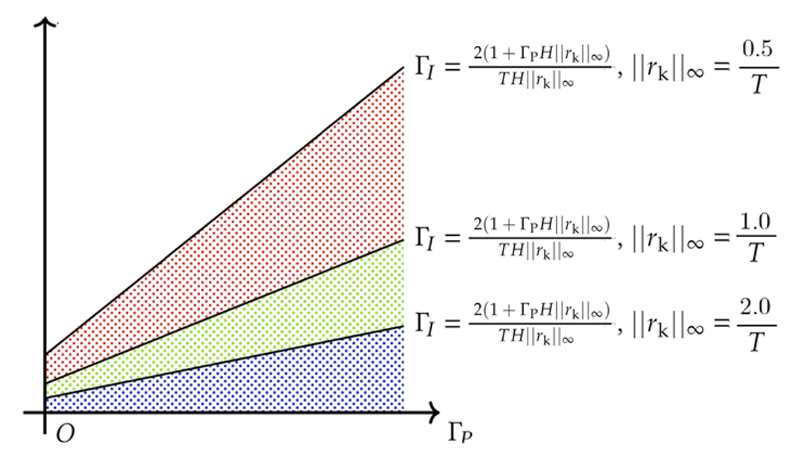
Figure 8. Stability area of the gains Γ P and Γ I .